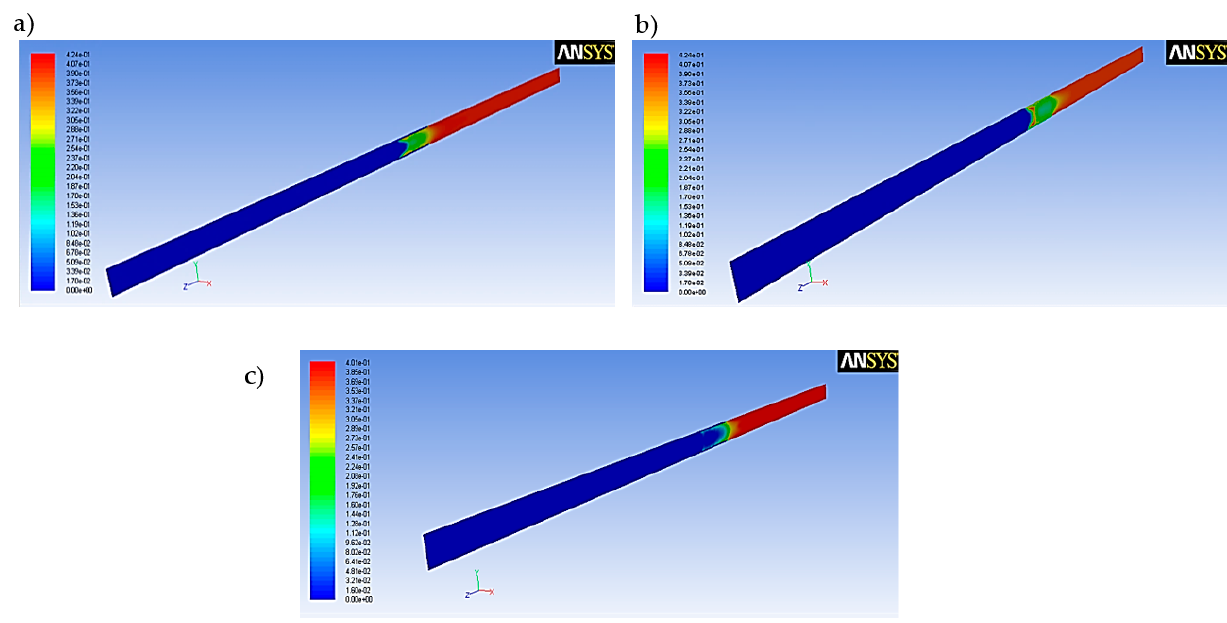
Figure 24. Map of H 2 variations in the syngas for the numerical simulation: ( a ) coal sample from hard coal mine A in 1040 s, ( b ) coal sample from hard coal mine B in 704 s, ( c ) coal sample from hard coal mine C in 545 s.